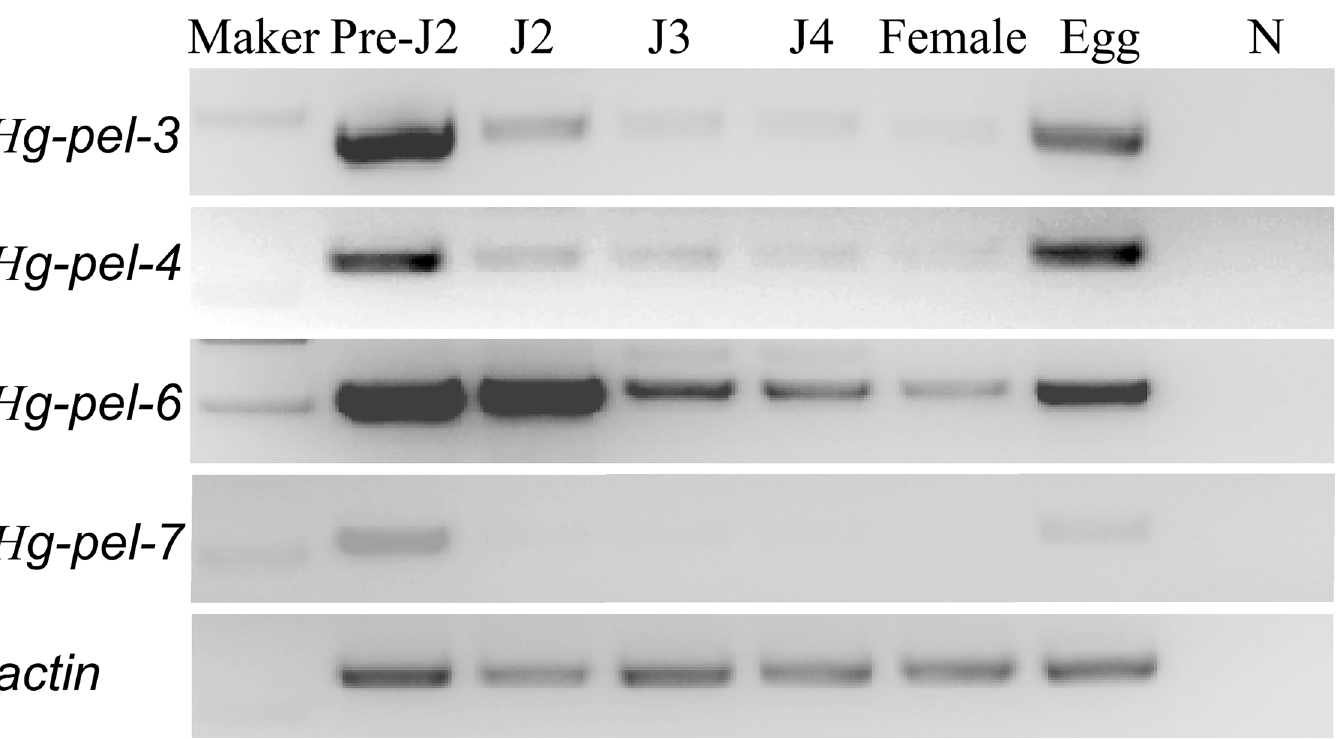
Fig 5. Developmental expression of hg-pel-3 , hg-pel-4 , hg-pel-6 and hg-pel-7 in different stages of Heterodera glycines . Pre-J2, pre-parasitic second stage juveniles; J2, parasitic second stage juveniles; J3, parasitic third stage juveniles; J4, parasitic forth stage juveniles; Female, adult females: eggs; N, negative control (genomic DNA of soybean roots). Maker, DL2000 DNA ladder. Actin, the H . glycines β -actin genem was used as positive control for each cDNA